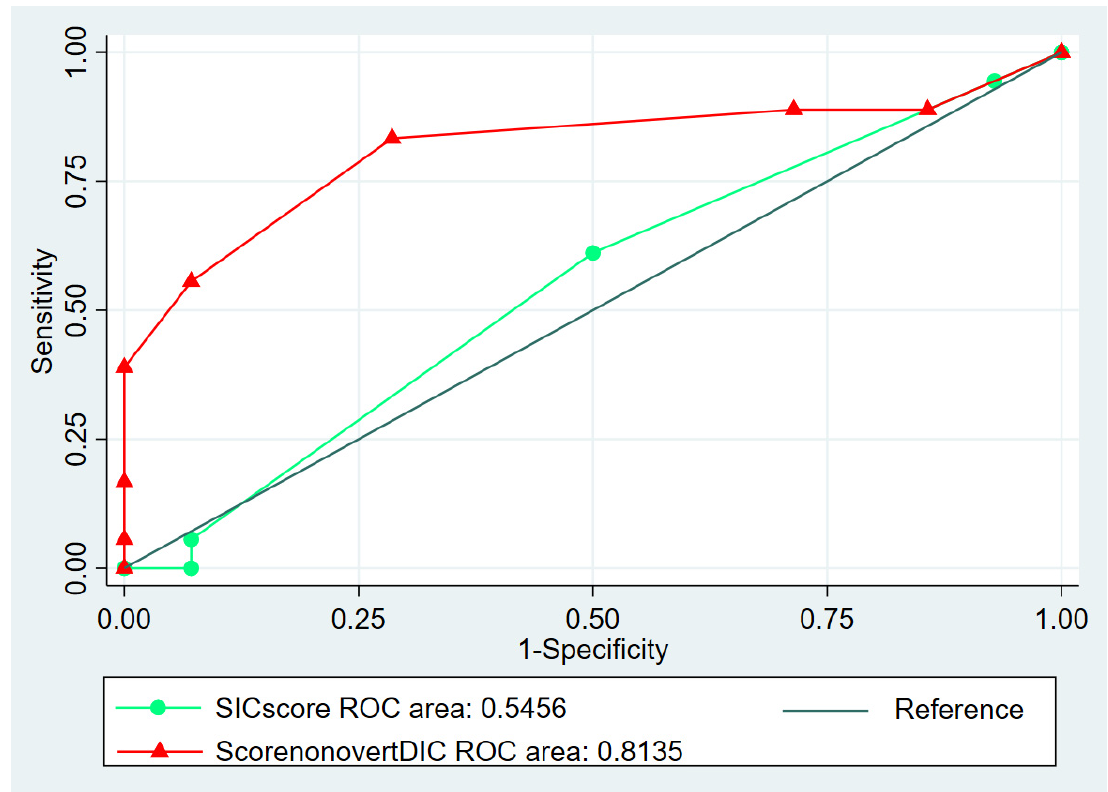
Figure 3. Receiver operating characteristic (ROC) analysis of the SIC score (curve with circles) and the non-overt DIC score (curve with the triangles) in predicting respiratory function requiring NIV/ICU. Area under curve is reported for both.